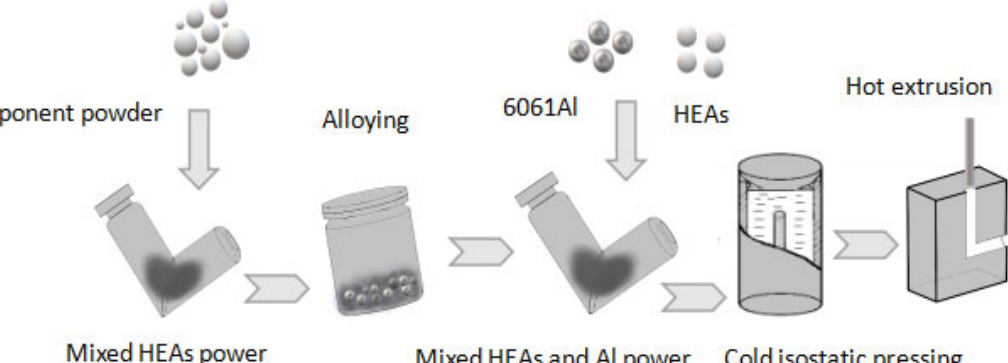
Figure 1. Schematic diagram of the experimental process.